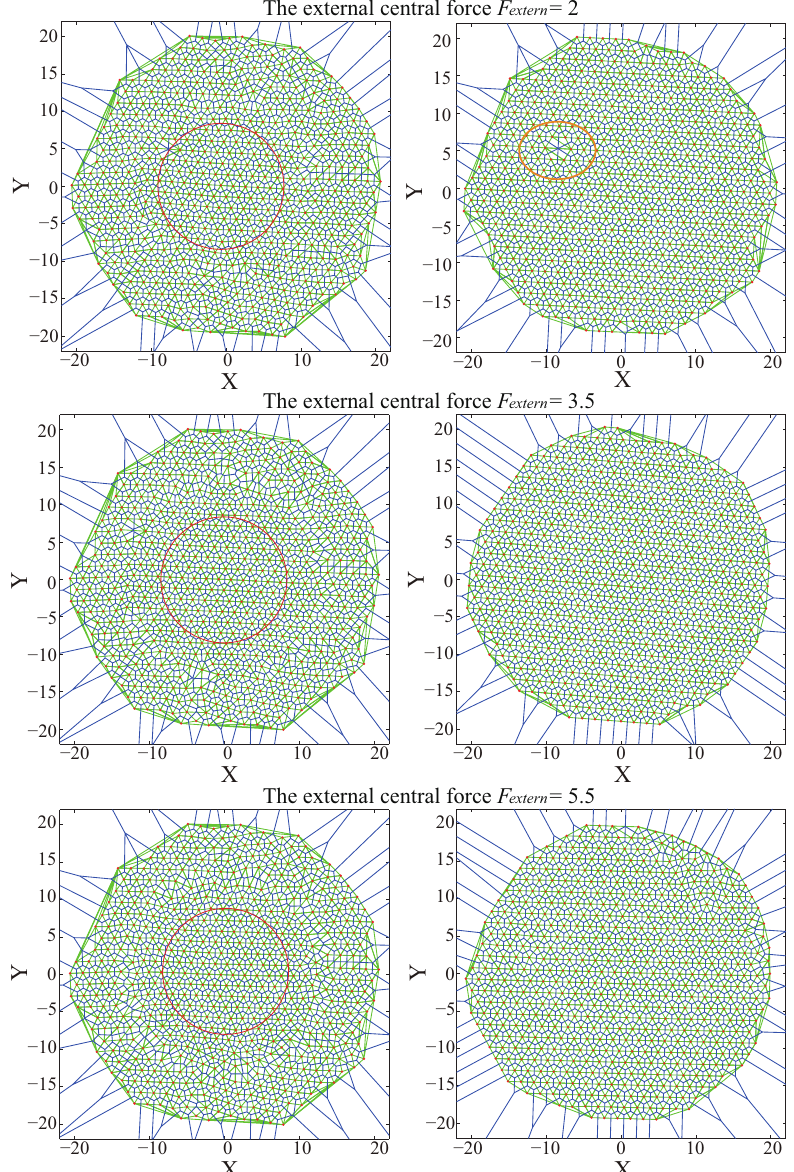
Figure 5. Typical simulation results of node deployment by the VFA-SF-OPT for the indicated external central force F extern = 2.0, 3.5 and 5.5, respectively. Left panels, deployment at 600th time step. Right panels, final network topology at 5000th time